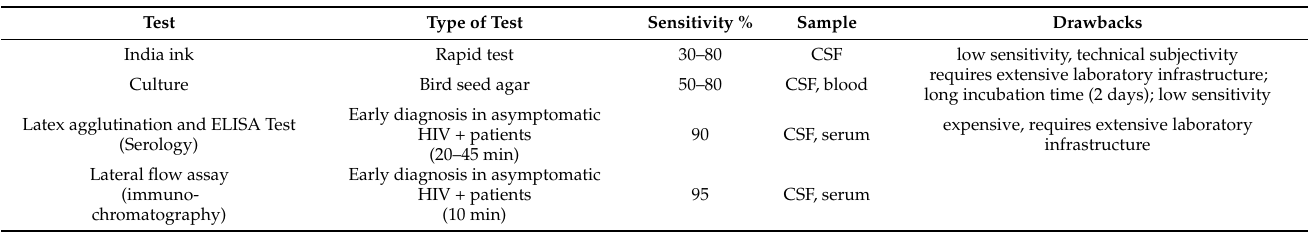
Table 3. Characteristics of the test commonly used for the diagnosis of Cryptococcal